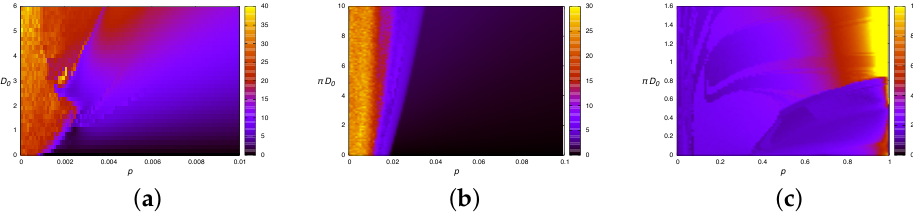
Figure 4. Heat map of the state–variable distance d for different values of parameter coupling D = π D 0 (0 π 1) and state–variable coupling p for some state–variable coupling directions ≤ ≤ C and parameter coupling direction χ . ( a ) C = [ 1,1,1 ] , χ = [ 1,1,1 ] ; ( b ) C x = [ 1,0,0 ] , χ = [ 1,1,1 ] ; ( c ) C z = [ 0,0,1 ] , χ = [ 1,1,1 ] ;. The line π = 0 corresponds to Figure